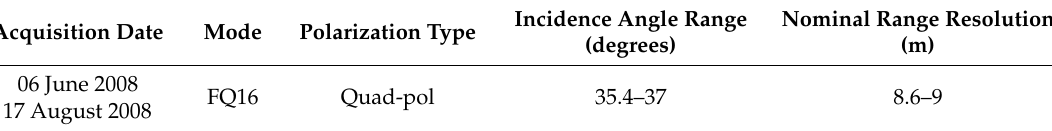
Figure 1. Two optical images over the study area, ( a ) before and ( b ) after a flood event. Table 1. The characteristics of the images used in this study.